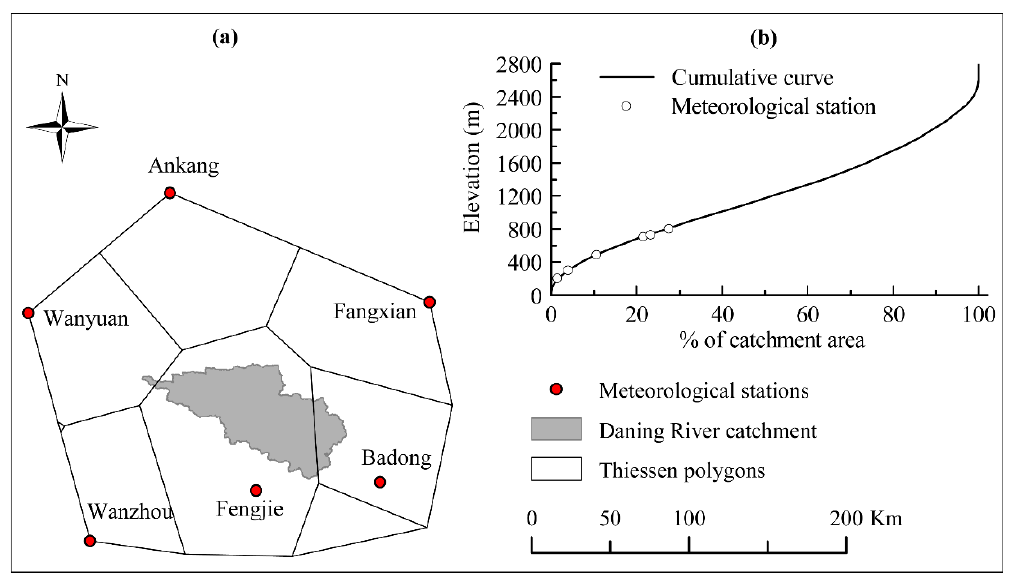
Figure 2. ( a ) National meteorological stations around the Daning River catchment and their Thiessen polygons; and ( b ) the catchment’s elevation compositions and stations’ elevations.